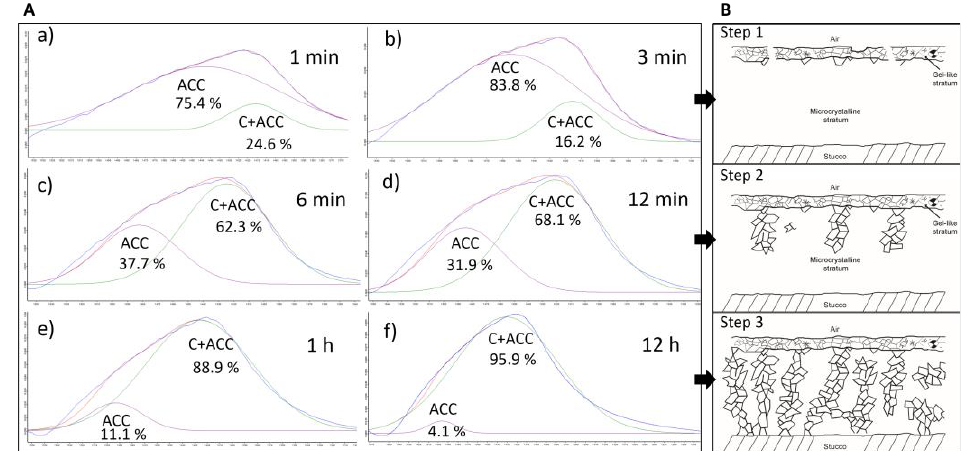
Figure 7. (A) Original overlapped band (blue line), sum band (red line) and individual bands of calcite plus ACC (C + ACC) (green line) and ACC (purple line) obtained by applying the mathemat- ical curve-fitting process in the carbonate ν 3 stretching band at: a) 1 min; b) 3 min; c) 6 min; d) 1 h; curve-fitting process in the carbonate ν 3 stretching band at: (a) 1 min; (b) 3 min; (c) 6 min; (d) 1 e) 1 h and f) 12 h. Percentage values of the overlapped band area are provided. ( B ) Epigenetic su-